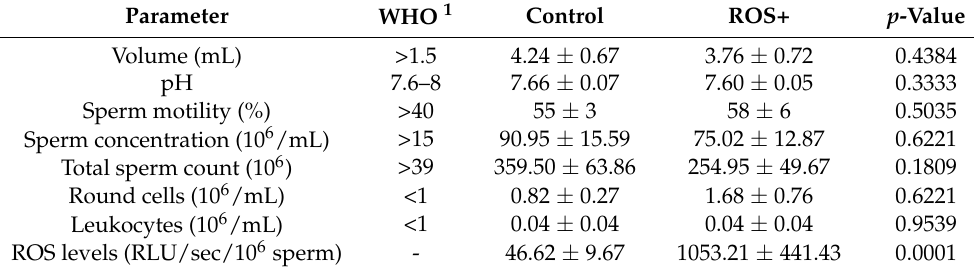
Table 1. Semen parameters of fertile donors from control and ROS+